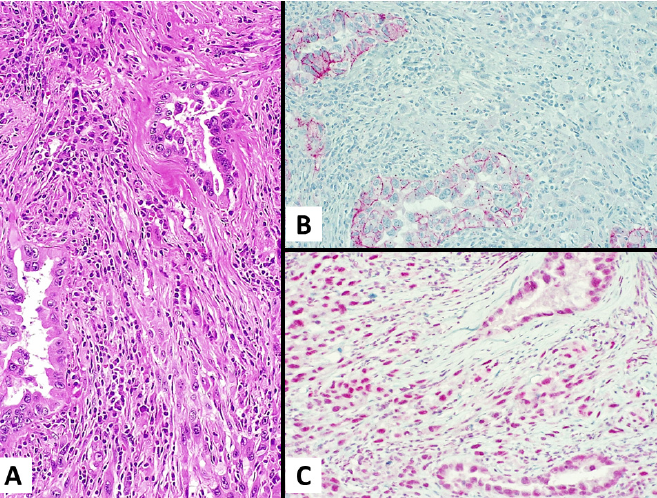
Figure 1. A case of sarcomatoid (pleomorphic) carcinoma of the lung. (( A ) magnification ×200) Hematoxylin and eosin stain shows a sarcomatoid (pleomorphic) carcinoma of the lung consisting of an adenocarcinoma (epithelial component) and a spindle cell component (sarcomatous component); (( B ) magnification ×200) The Claudin-4 expression is retained only in the epithelial component; (( C ) magnification ×200) BAP1 is diffusely present (no BAP1 loss) in both components. Table 1. Sarcomatoid carcinomas and distribution of Claudin-4 and BAP1 immunostaining.